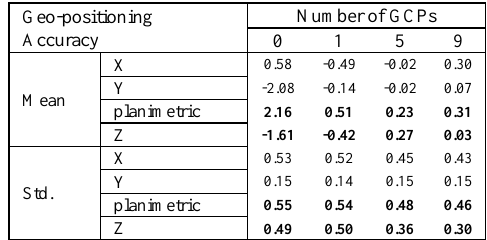
Table 2. Results of geo-positioning accuracy (in meters)